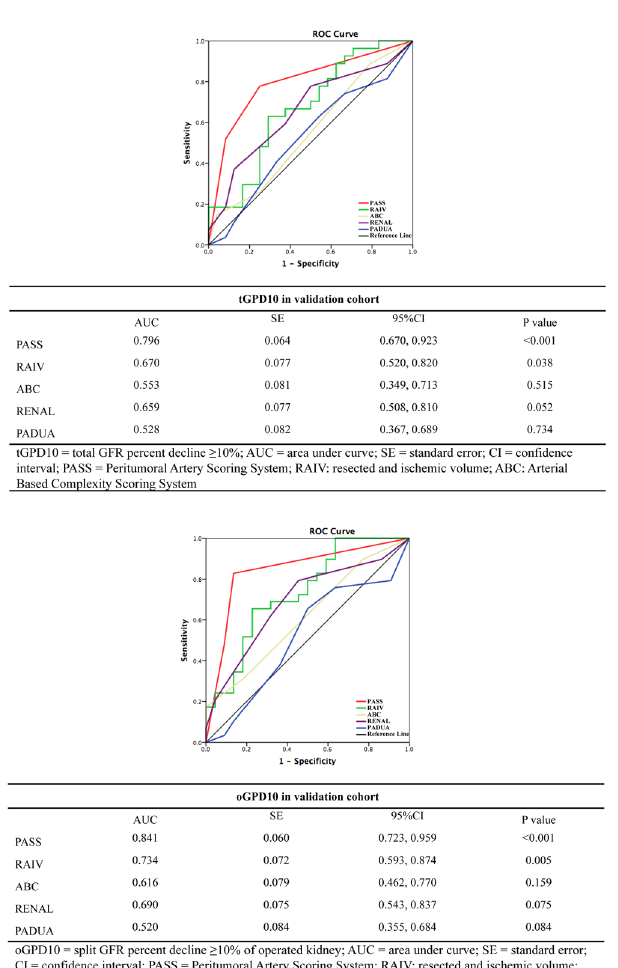
Figure 4. ROC curves for the prediction value of GFR decline in split and total renal function between PASS and 4 nephrometry scoring systems in validation